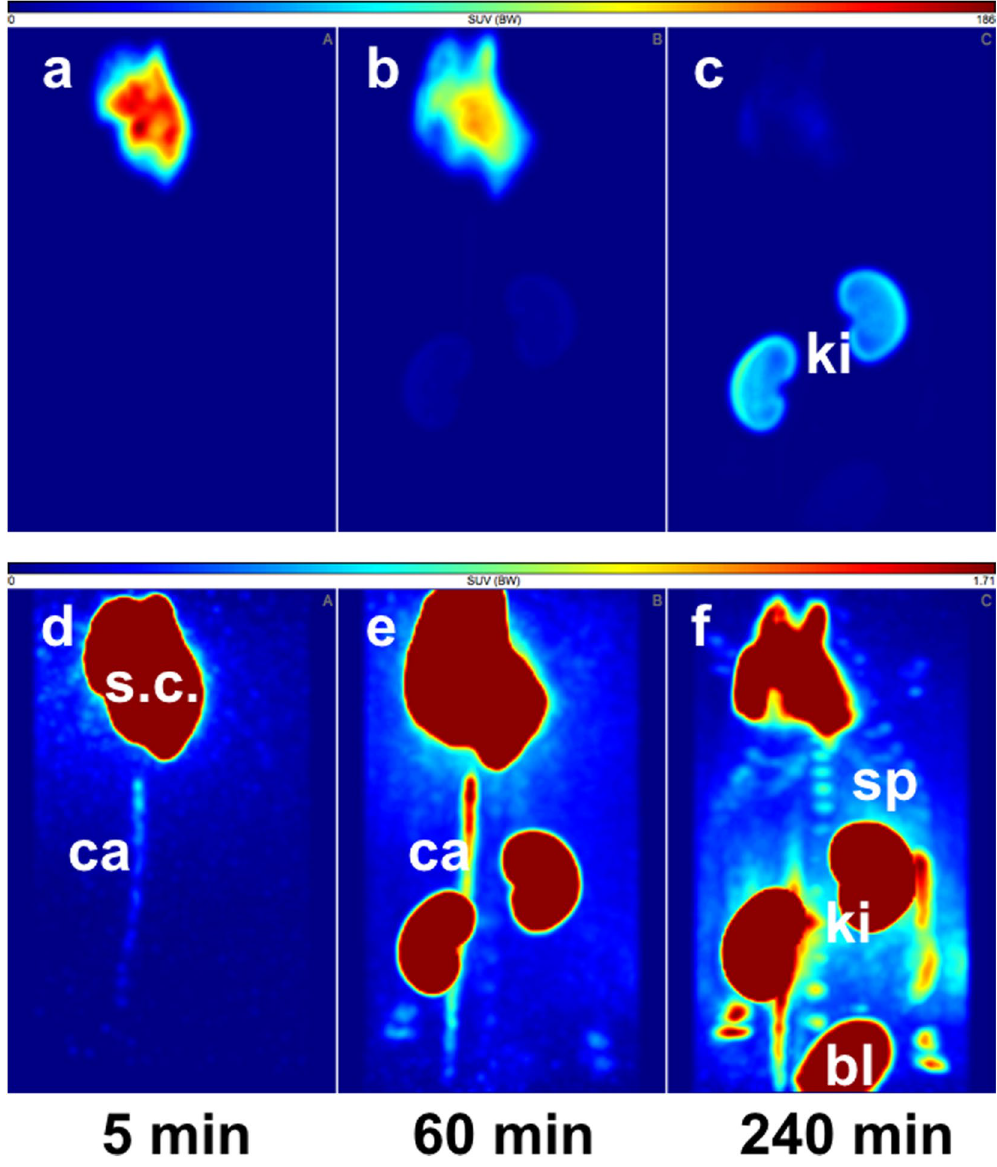
Figure 5. PET-biodistribution after s.c. injection. Maximum Intensity Projections (MIP) of a PET-study with [ 64 Cu]Cu-NOTA-HsTX1[R14A] in a healthy Wistar rat at 5, 60 and 240 min after a single subcutaneous injection in the back; ( a–c ) images scaled to the maximum intensity SUV 186 g/mL. ( d–f ) Images rescaled to SUV 1.71 g/mL, (ki, kidney; s.c., subcutaneous injection site; ca, catheter; sp, spine; bl,